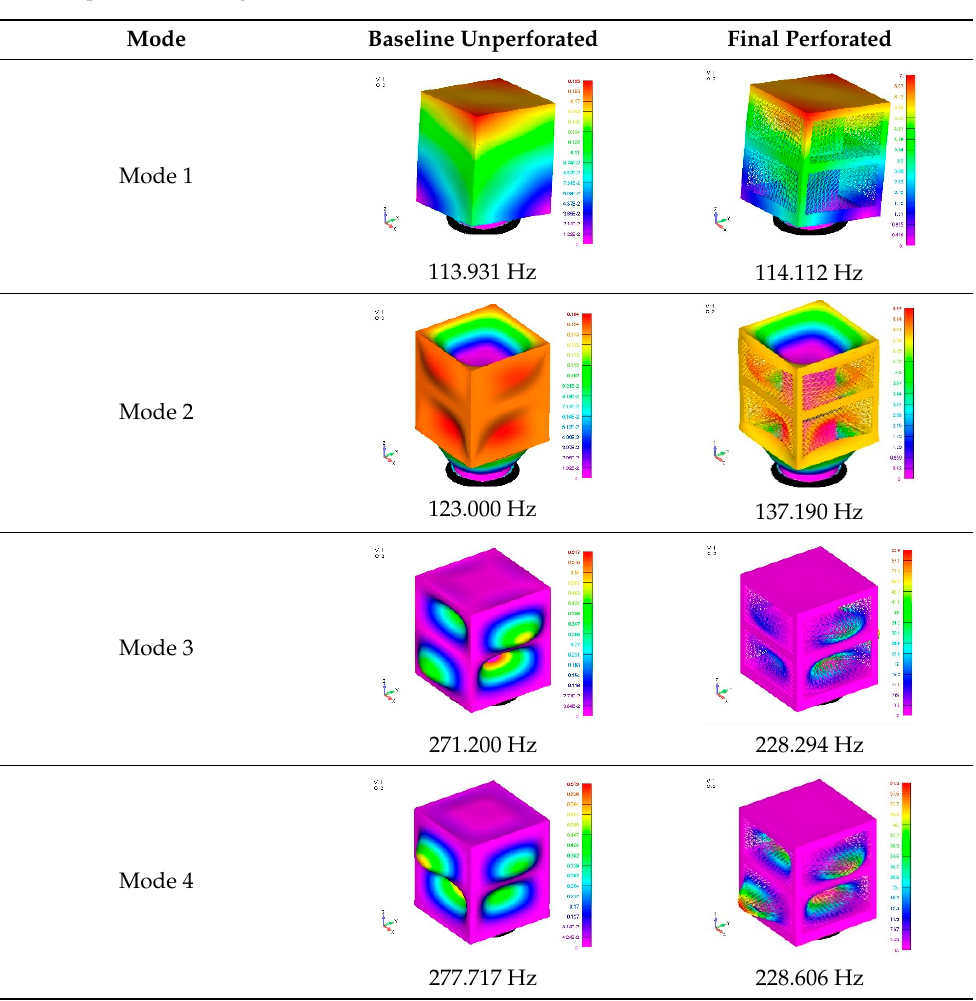
Table 7. Comparison between the mode shapes and natural frequencies of the baseline unperforated and final perforated designs.